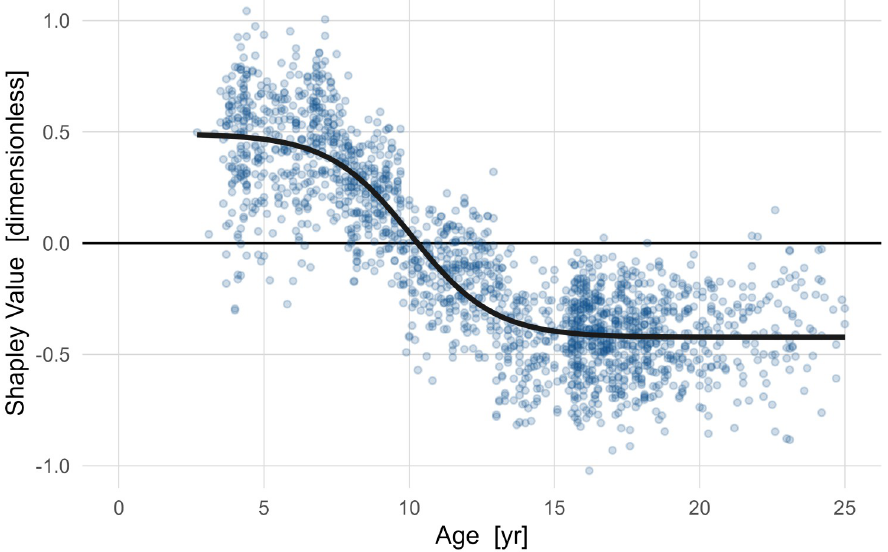
Fig 12. The direct effect of age on net energy consumption. Meaningful maturation effects accounting for around 1 SD of net energy consumption reduction can be clearly seen. The period of rapid reduction occurs from around 7.5– 12.5 years. Evaluating the effect of treatment on energy consumption during this epoch must account for the direct effects of age to avoid conflating age-related reductions with treatment effects.